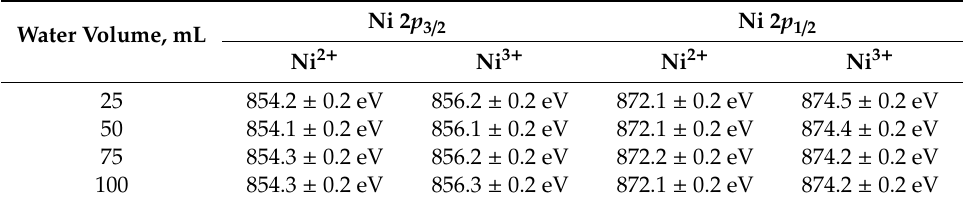
Table 4. Binding energy values of the Ni 2 + and Ni 3 + states in the Ni 2 p spectra. Water Volume, mL